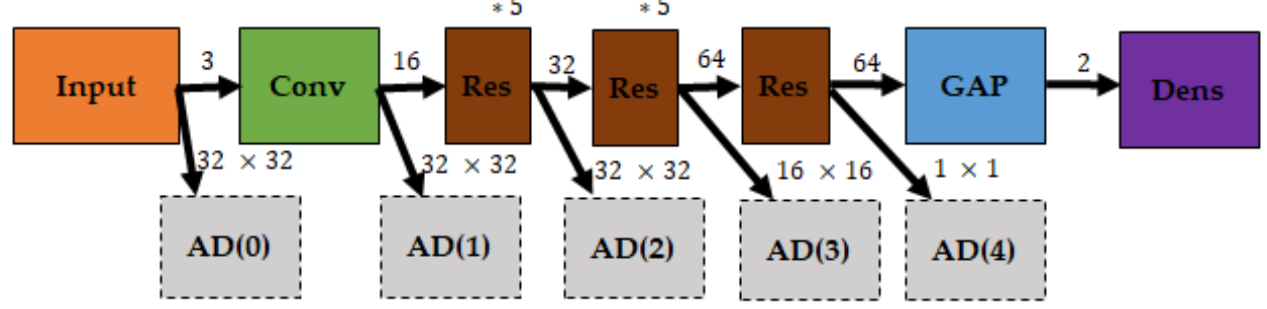
Figure 25. Overview of the adversary detector network.